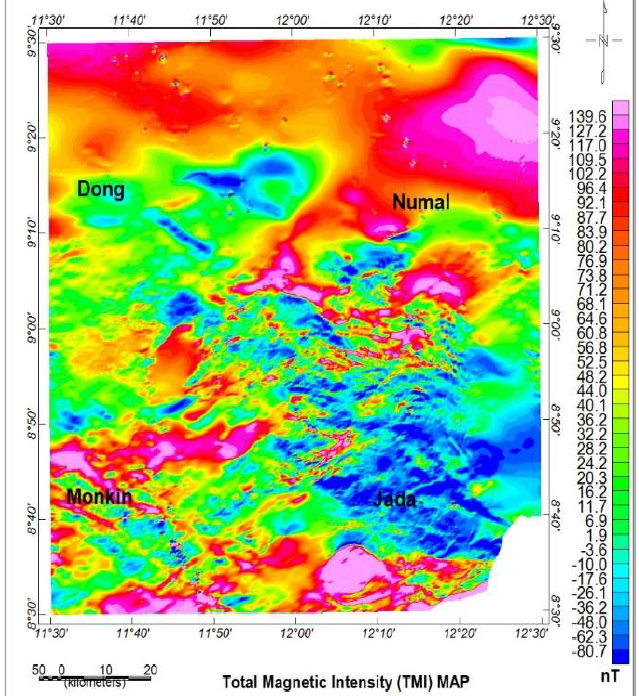
Figure 3: Total magnetic intensity map of the study area (The sum of 33,000 nT IGRF removed for the purpose of handling must be added to get the actual value at any